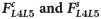
FL4L5candFL4L5s in relation to SS.Axial compression force (FL4L5c, upper plot) and anterior shear (FL4L5s, lower plot) at the L4L5 level, computed at minimum and maximum sacral slope (SSmin and SSmax) for the four lumbar typologies (RT1, RT2, RT3, RT4). SSmin and SSmax were, respectively, 25° and 35° for both RT1 and RT2, 35° and 45° for RT3, and 45° and 55° for RT4 (Table 1). The results correspond to the central pelvic incidence (PI) values for the RT (40° in RT1 and RT2, 50° in RT3, 60° in RT4, see Table 1). The three sagittal vertical axis (SVA) conditions interpreting the balanced global alignment (SVAmed) and the backward and frontward imbalanced alignments (SVAback and SVAfront) are presented as green, blue, and red bars, respectively. The lumbar lordosis (LL) is reported as well.